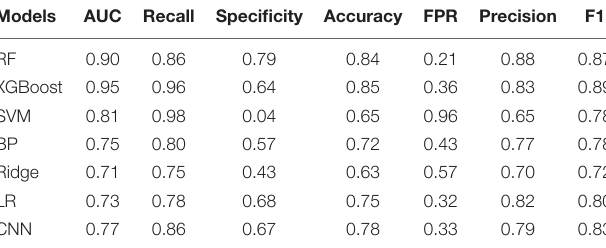
TABLE 4 | Evaluation summary based on AUC, recall, specificity, accuracy, FPR and